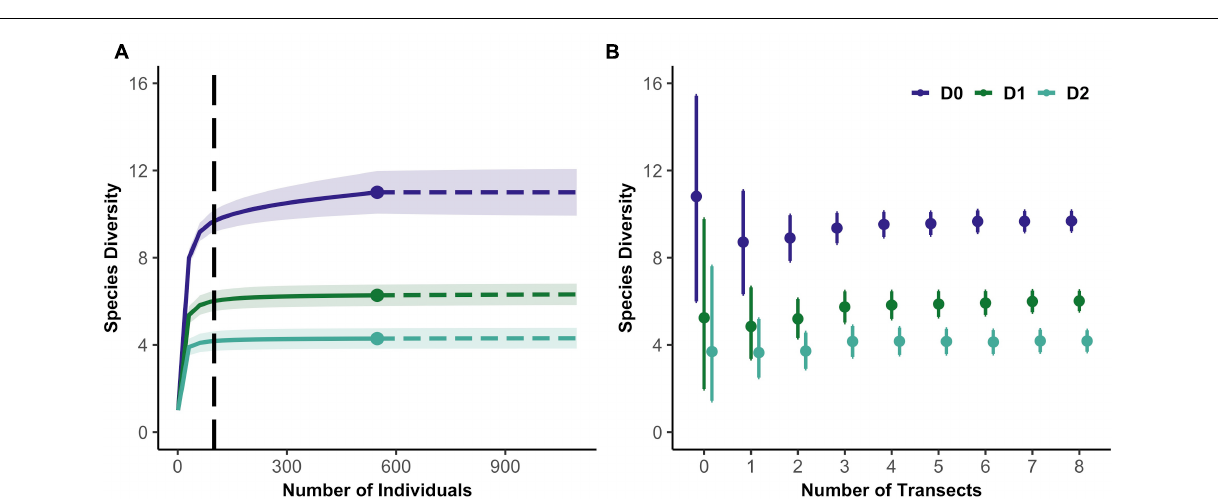
sampling events for which we had to substitute regional baseline estimates ( Supplementary Figure 2